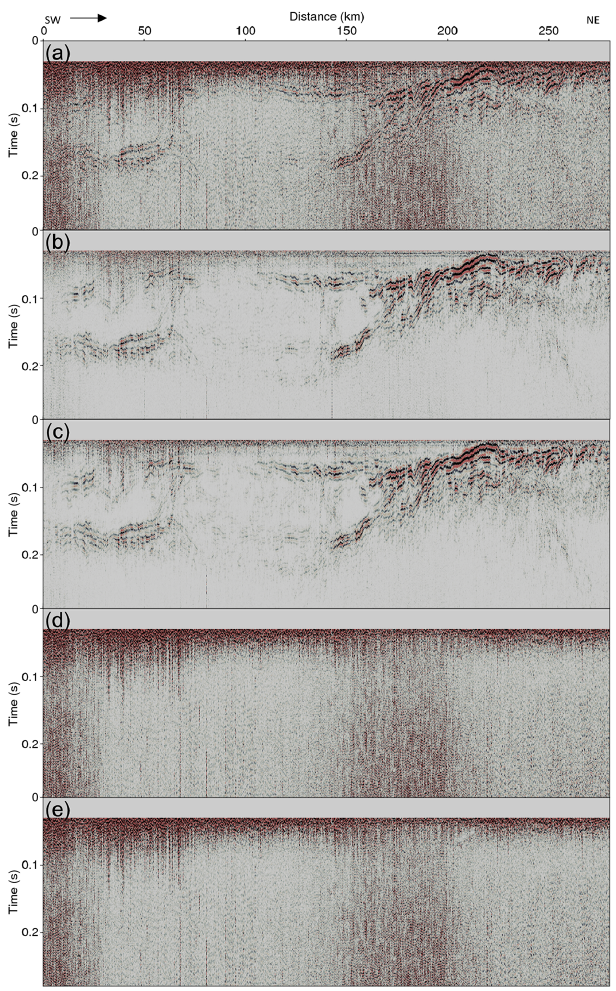
Figure 19. (a) Line 2 seismic section before applying DnCNN, noise-attenuated result using (b) the D1 model and (c) the D2 model, and estimated noise using (d) the D1 model and (e) the D2